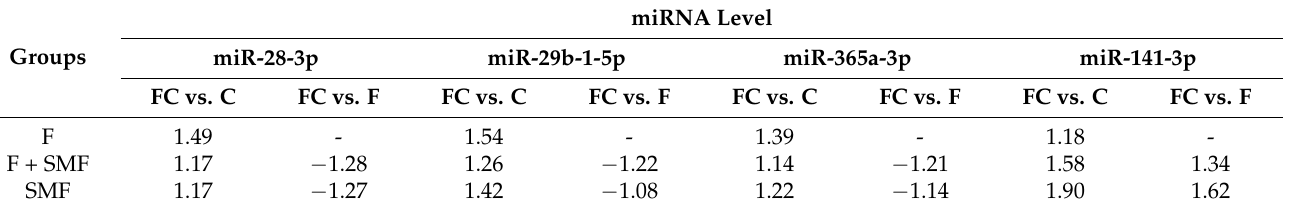
Figure 2. Relative miRNA expression of miR-28-3p ( A ), miR-29b-1-5p ( B ), miR-365a-3p ( C ) and miR-141-3p ( D ) in the cells that had been treated with fluoride and the cells that had been exposed to a static magnetic field. The results are presented as the mean ± SD; C—control cells; F—cells that had been treated with fluoride; SMF—cells that had been exposed to a static magnetic field; F + SMF—cells that had simultaneously been exposed to fluoride and a static magnetic field; * p < 0.05 vs. C. Table 3. Comparison of the miRNA expression levels (fold change) among studied cell